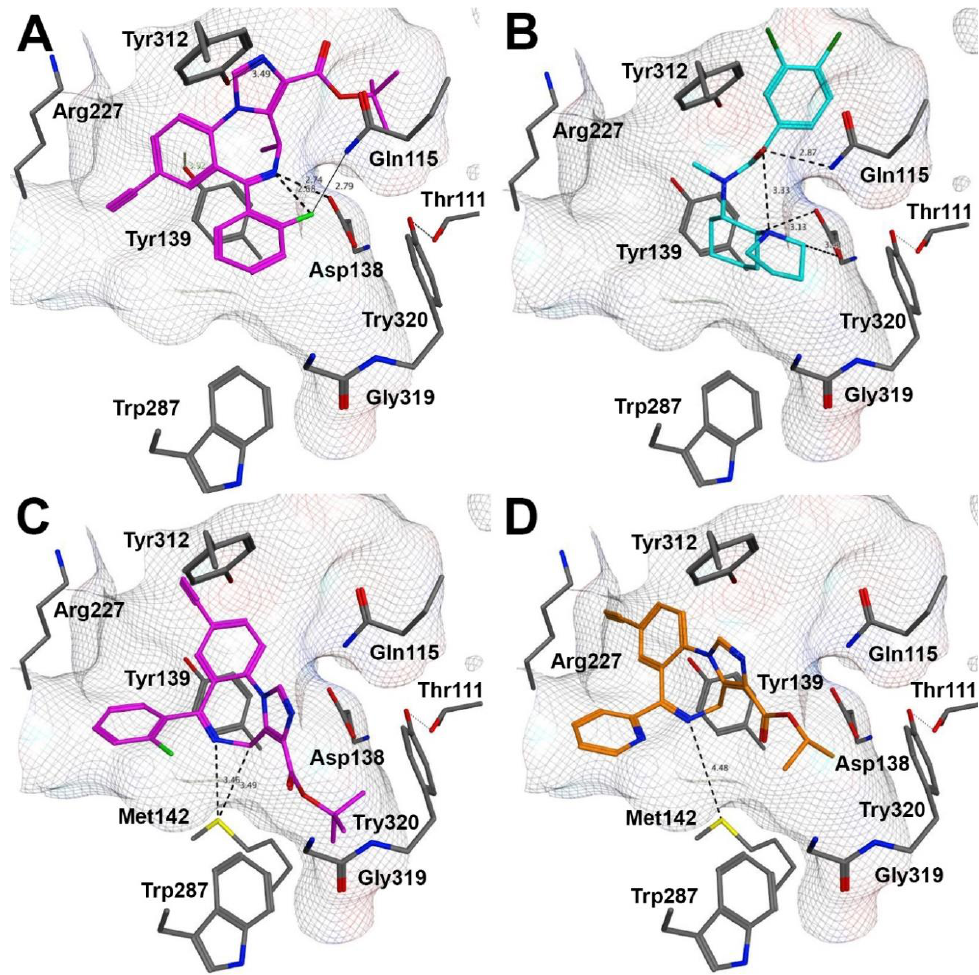
Figure 3. Compound docking poses with KOR [PDB ID 6B73] [27]. ( A ) Best docking pose for GL-I-30, ( B ) recreated docking pose for U50,488, ( C ) second best docking pose for GL-I-30, ( D ) best docking pose for MP-II-068.